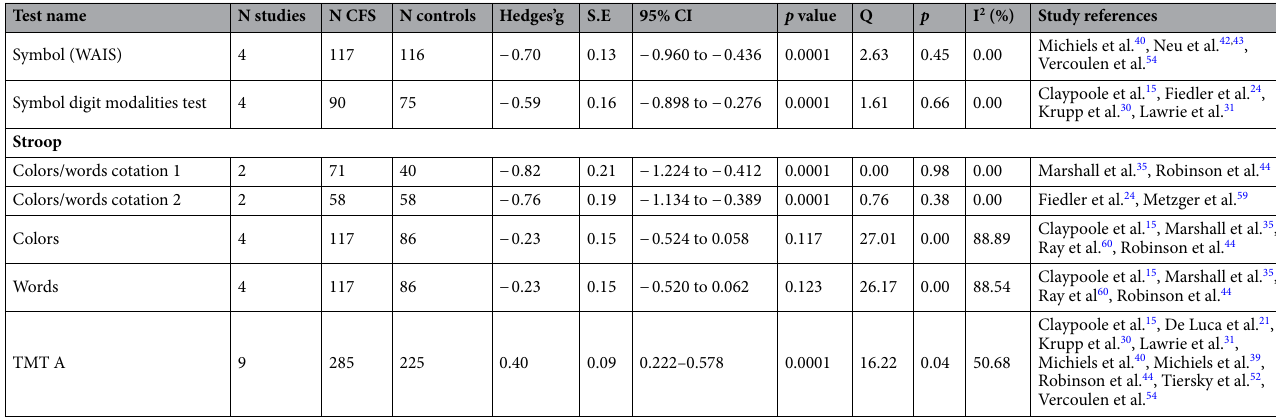
Table 5. Processing speed: Hedge’s g effect sizes for each test, in descending order. WAIS Wechsler adult intelligence scale, TMT trail making test, ME/CFS myalgic encephalomyelitis/chronic fatigue syndrome, N